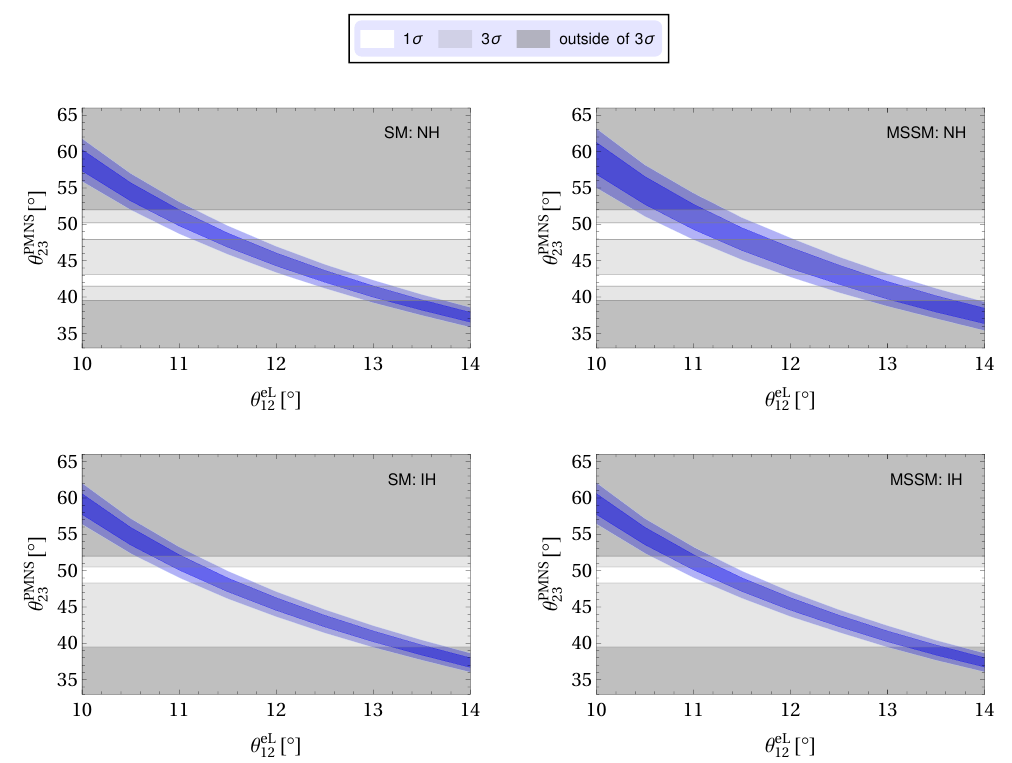
Figure 1 . Predictions for the 1 σ and 2 σ HPD intervals of the low scale PMNS mixing angle θ PMNS 23 as a function of the GUT scale parameter θ e , including RG effects. The white region indicates the 12 current experimental 1 σ range, whereas the light gray region represents the current experimental 3 σ range. Left: SM. Right: MSSM. Top: NH. Bottom: IH.